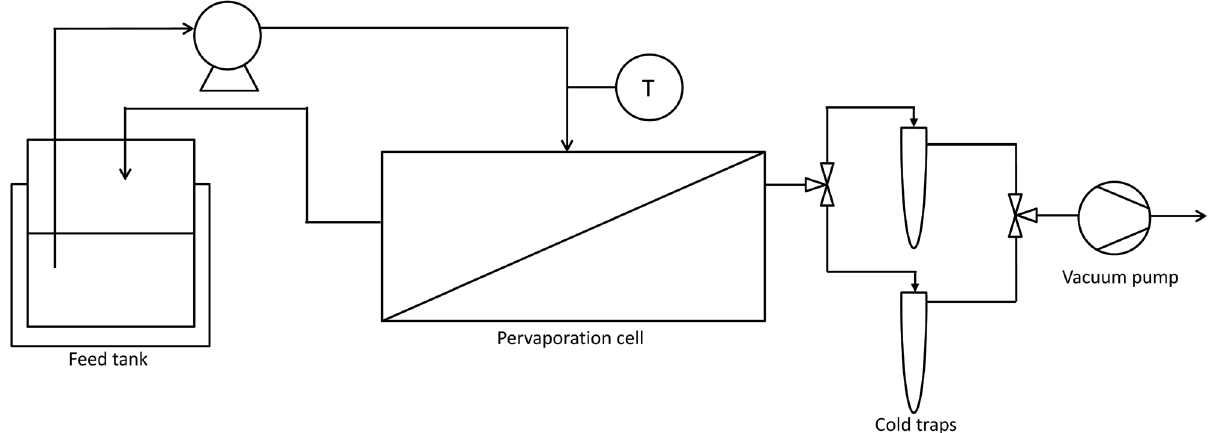
Figure 3: Scheme of the pervaporation